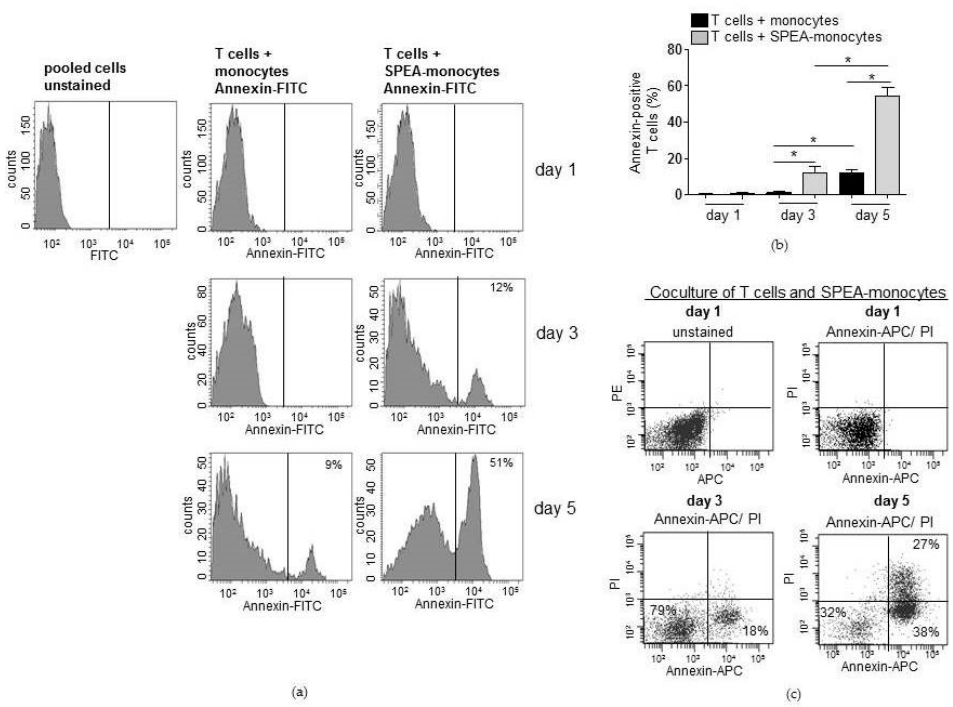
Figure 2. SPEA-monocytes induce apoptosis of cocultured CD4 + T cells. CD14 + cells were isolated from the blood of healthy donors, stimulated with 1000 ng/mL SPEA for 48 h (SPEA-monocytes) or left unstimulated. After washing the monocytes three times, cocultures with allogeneic CD3/CD28- activated CD4 + T cells were started (ratio of 1:2). After one to five days (as depicted in the graph), cells were stained with ( a ) annexin-FITC, ( b ) annexin-APC and propidiumiodide (PI), and fluorescence was analyzed using a FACSCanto. ( a ) Depicted are FACS histograms of the FITC (annexin) signal of T cells in the gated lymphocyte population. ( b ) Shown is the percentage of annexin-FITC positive T cells ( y -axes) of data presented in ( a ) and two more experiments. Columns: mean of three different donors/experiments + SD as error bars. Black columns: T cells cocultured with unstimulated monocytes. Grey columns: T cells cocultured with SPEA-monocytes. Statistical analysis: the comparison of two data groups was analyzed by Mann–Whitney U test with * p ≤ 0.05. The line above the columns depicts the compared groups. Kruskal–Wallis: number of groups: 6; p -value 0.0114; sum value, * the medians vary significantly ( p < 0.05). ( c ) Depicted are FACS dot plots of annexin-APC ( x -axis) and propidiumiodide (PI, y -axis) double-stained cells and unstained cells, gated lymphocyte population. Day 1, day 3, and day 5 stand for the duration of SPEA-monocyte/T-cell coculture.